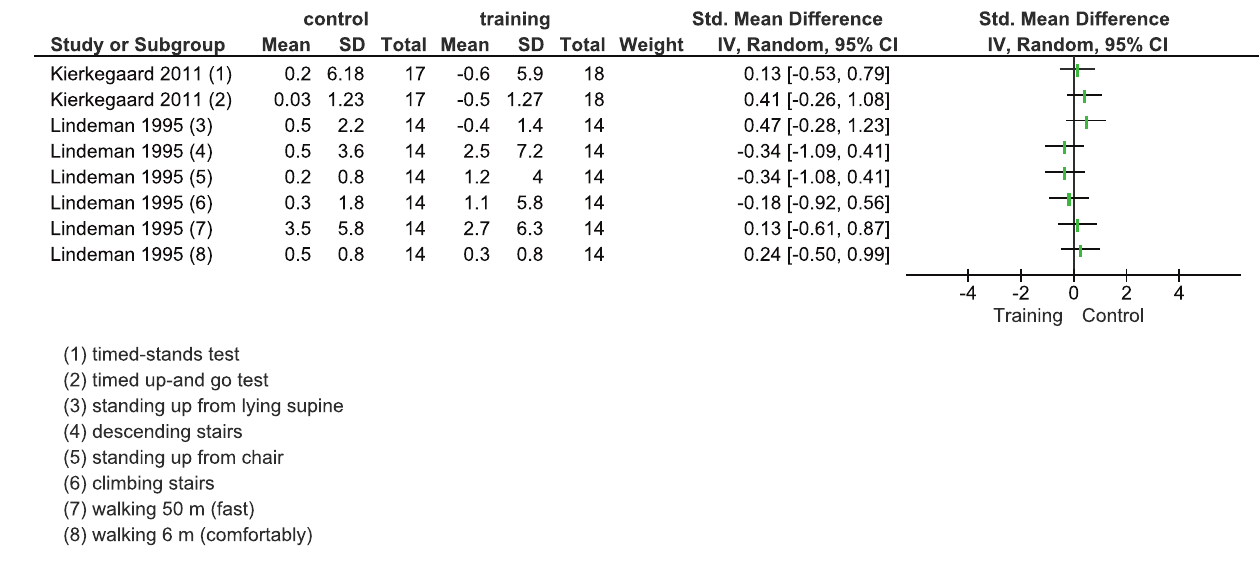
Figure 5. Overall effect of muscular exercise on motor function.